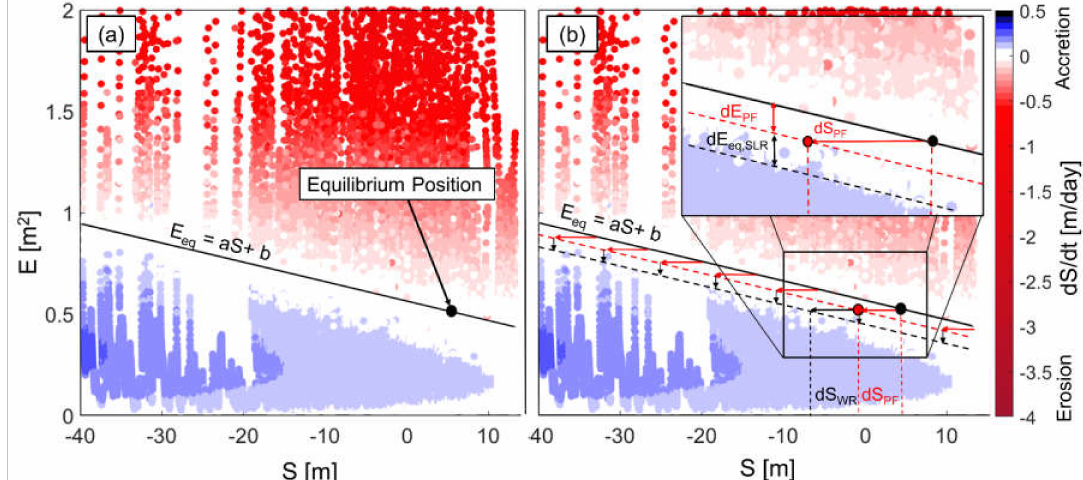
Figure A1. Example of shoreline position (S) vs. incident wave energy density (E = 1/16 H s2 , where H s is the significant wave height) Cartesian plane, with the linear equilibrium beach-wave condition following Yates et al. [9] (solid black line). The color-bar indicates the magnitude of potential erosion (red) and accretion (blue). Red arrows indicate the geometric shift due to Passive Flooding (dS PF ); vertical black arrows indicate the disequilibrium change (dE eq,SLR ) corresponding to the change in the bottom slope relative to MSL; and the horizontal black arrow indicates the potential Wave Reshaping effect (dS WR ) that would re-establish the equilibrium state. The black dash line indicates the new equilibrium beach–wave condition post-SLR. The data used for this example refer to Truc Vert beach